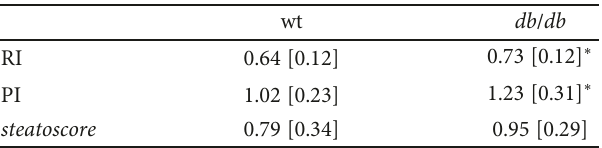
Table 4: Ultrasonographic hepatic and renal parameters in the two groups of